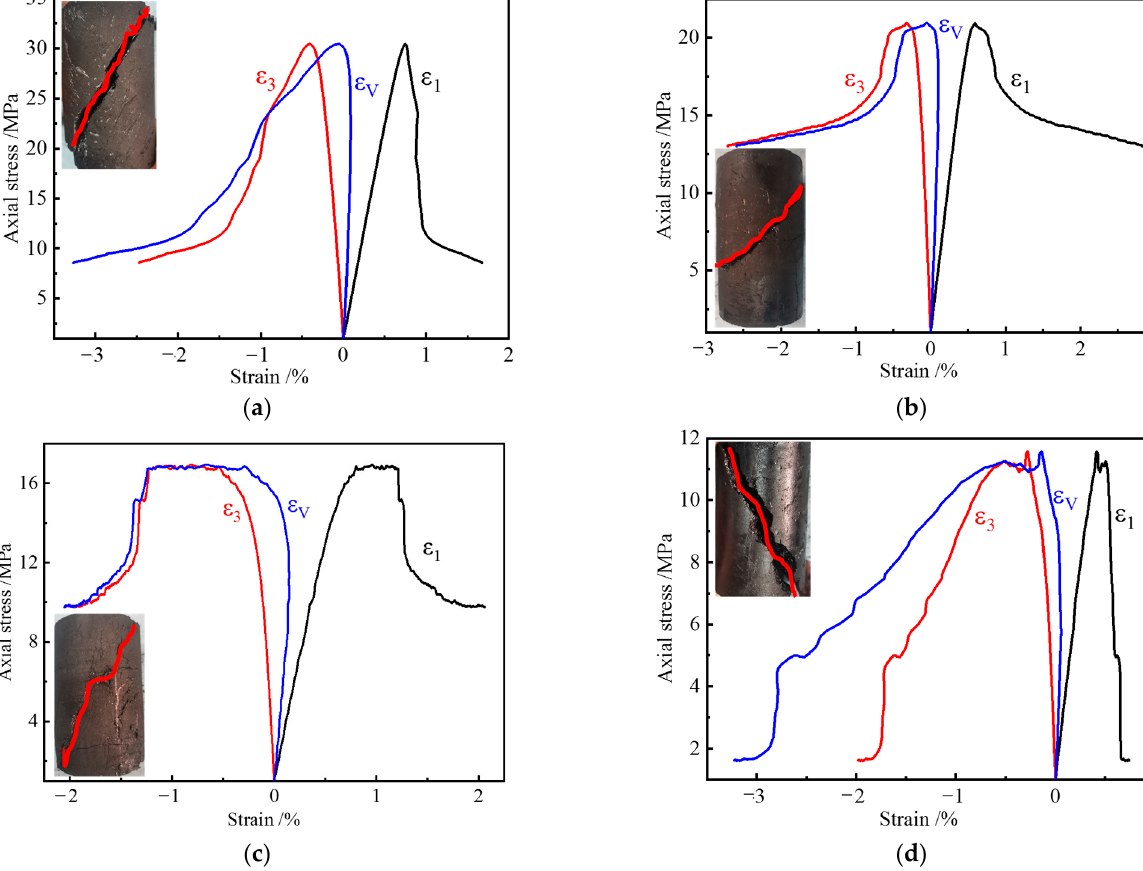
Figure 2. Stress–strain curves and failure of coal samples under triaxial compression. ( a ) Gas pressure 0 MPa, ( b ) gas pressure 1 MPa, ( c ) gas pressure 2 MPa, and ( d ) gas pressure 3 MPa.